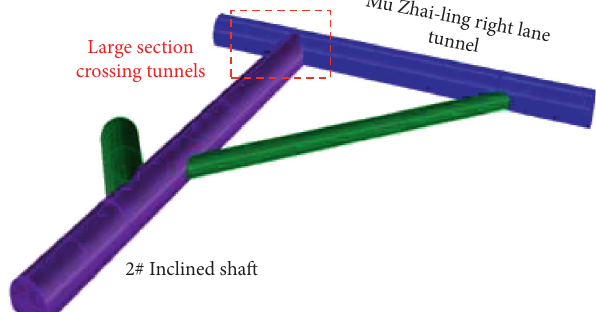
Figure 4: Layout of No. 2 inclined shaft of the Mu Zhai-ling tunnel.